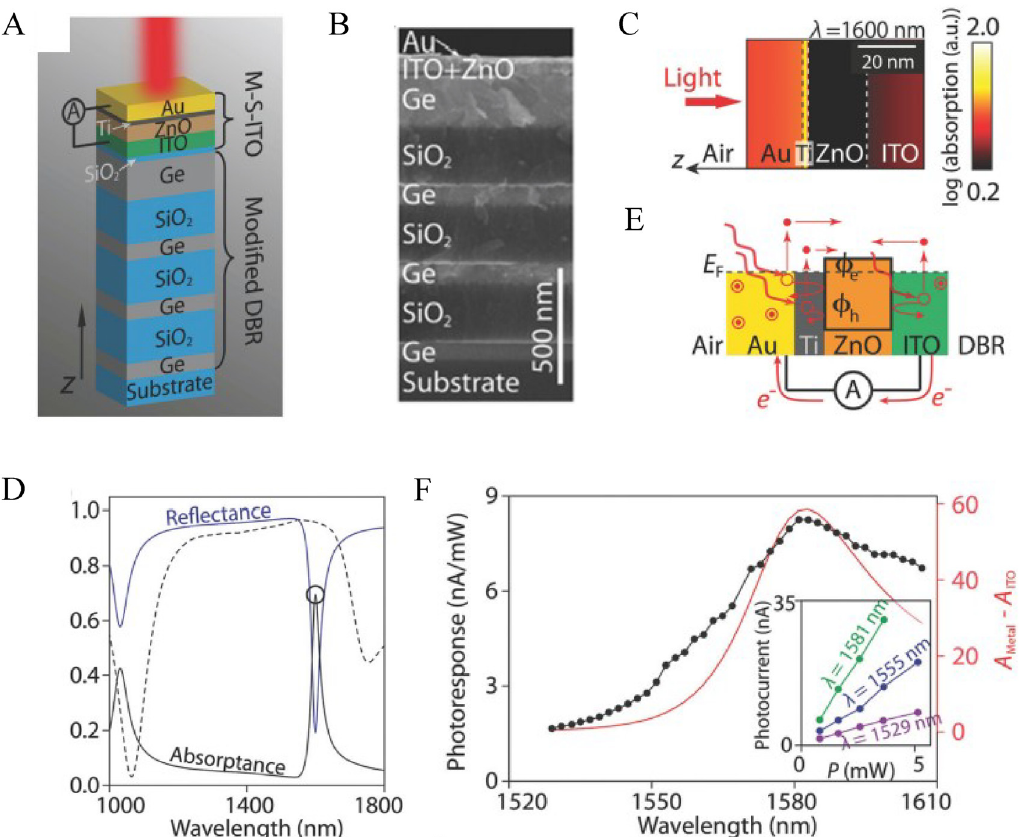
Figure 10: (A)Schematicrepresentation and(B)SEM image of theplanar TP hot-electron device.(C) Absorption mapof the planarTP deviceat the wavelength of 1600 nm. (D) Simulated reflection and absorption spectra of the planar TP device. (E) Energy band diagram of the TP hot- electron device. (F) Spectral photoresponse of the planar TP hot-electron device [39]. Copyright 2019, The Royal Society of